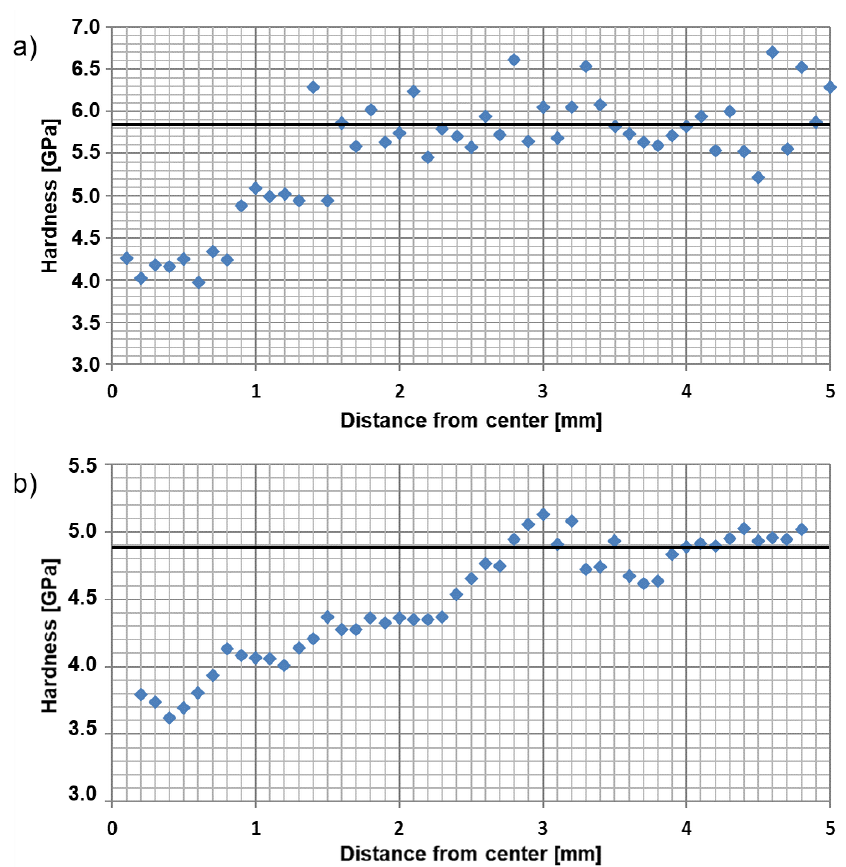
Figure 4. The graphs of hardness measured along the radius of the HPT-deformed samples of the Cu–14 wt% Sn alloy pre-annealed at 320 ◦ C ( a ) and 500 ◦ C ( b Cu–14 wt% Sn alloy pre-annealed at 320 °C ( a ) and 500 °C ( b ).